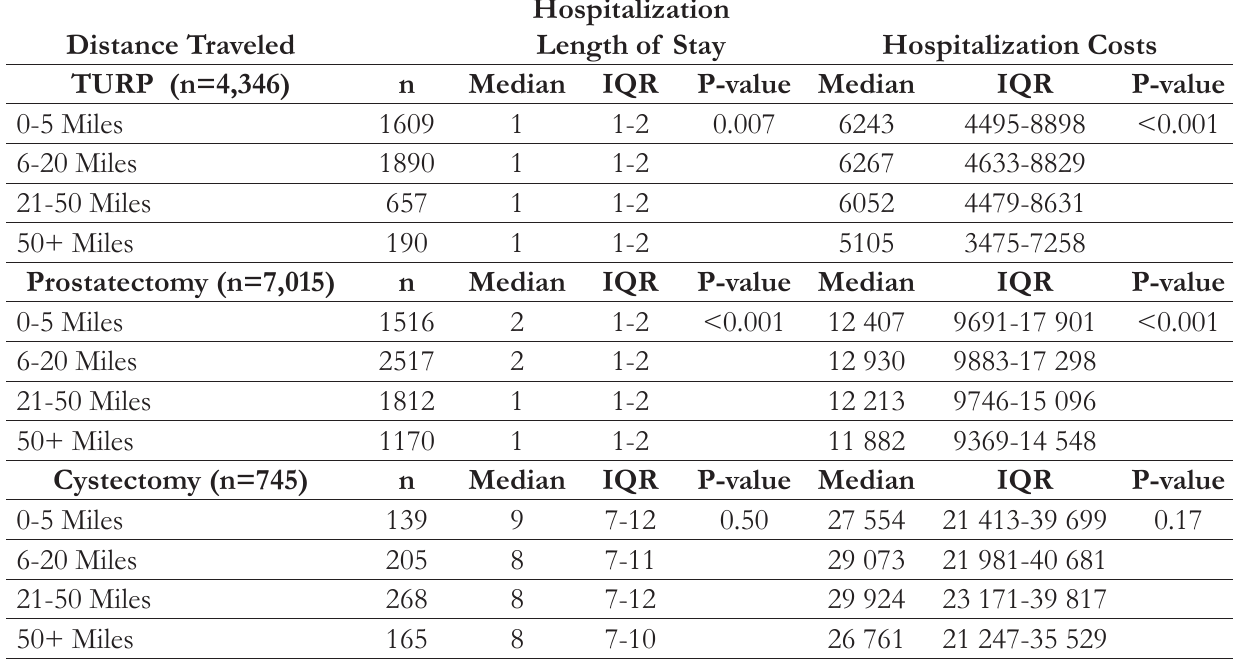
Table 2. Study Outcomes by Distance Traveled to Receive Select Surgical Urologic Procedures (N=12 106) Distance